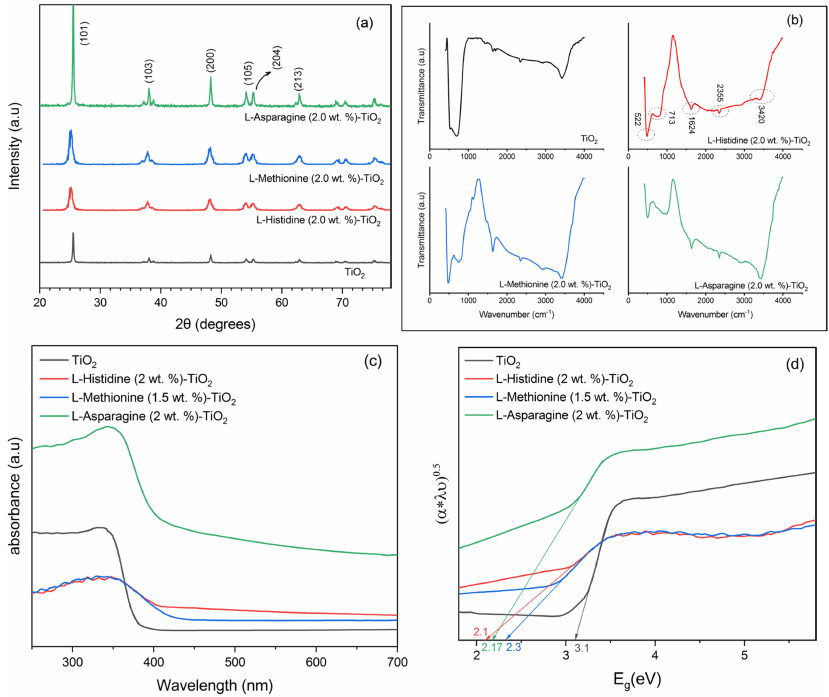
Figure 5. ( a ) XRD patterns, ( b ) FTIR spectra, ( c ) DRS spectra and ( d ) Tauc plots of